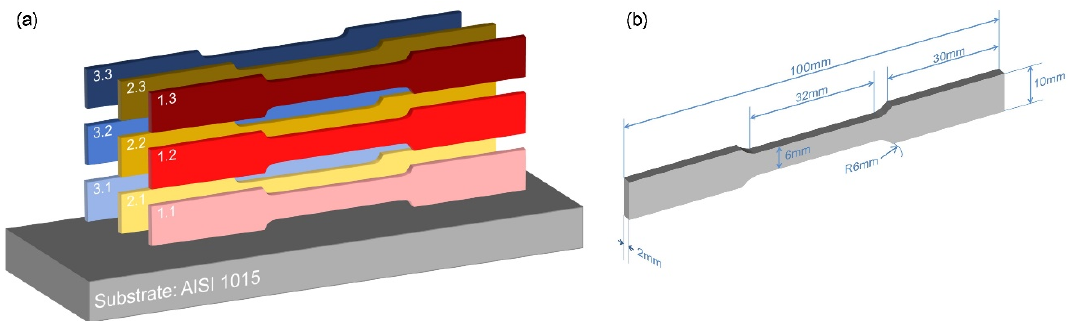
Figure 5. ( a ) Schematic illustration of the locations of the specimens in each wall, oriented on the Y-axis; ( b ) illustration of the tensile test samples cut from the walls.